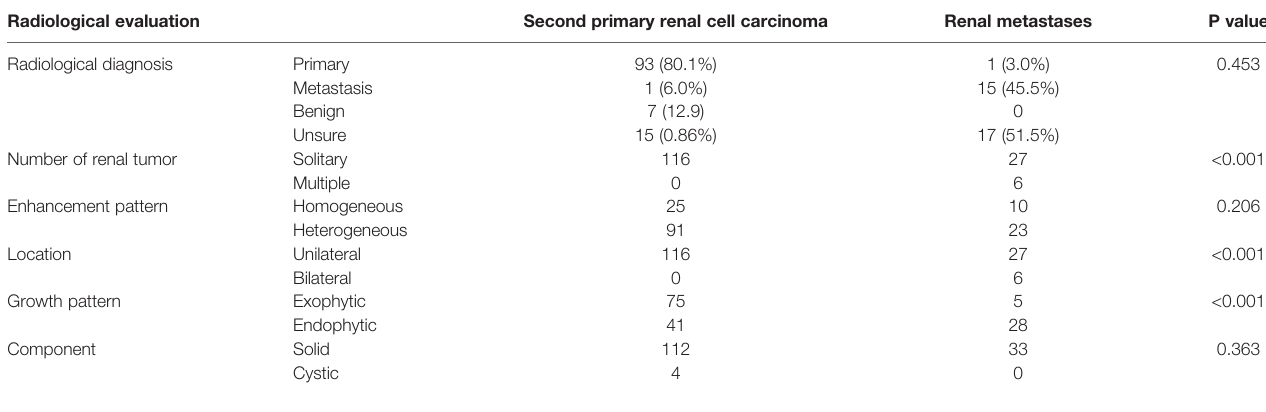
TABLE 2 | Radiological characteristics of patients with second primary renal cell carcinoma and with those of renal metastases. Radiological